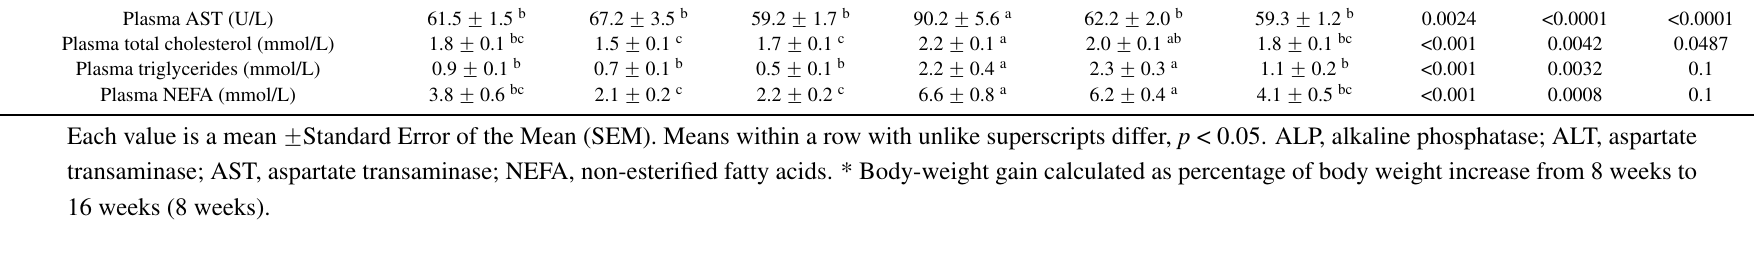
Table 4. Changes in cardiovascular structure and function in C, CG, CB, H, HG and HB diet-fed rats ( n = 8